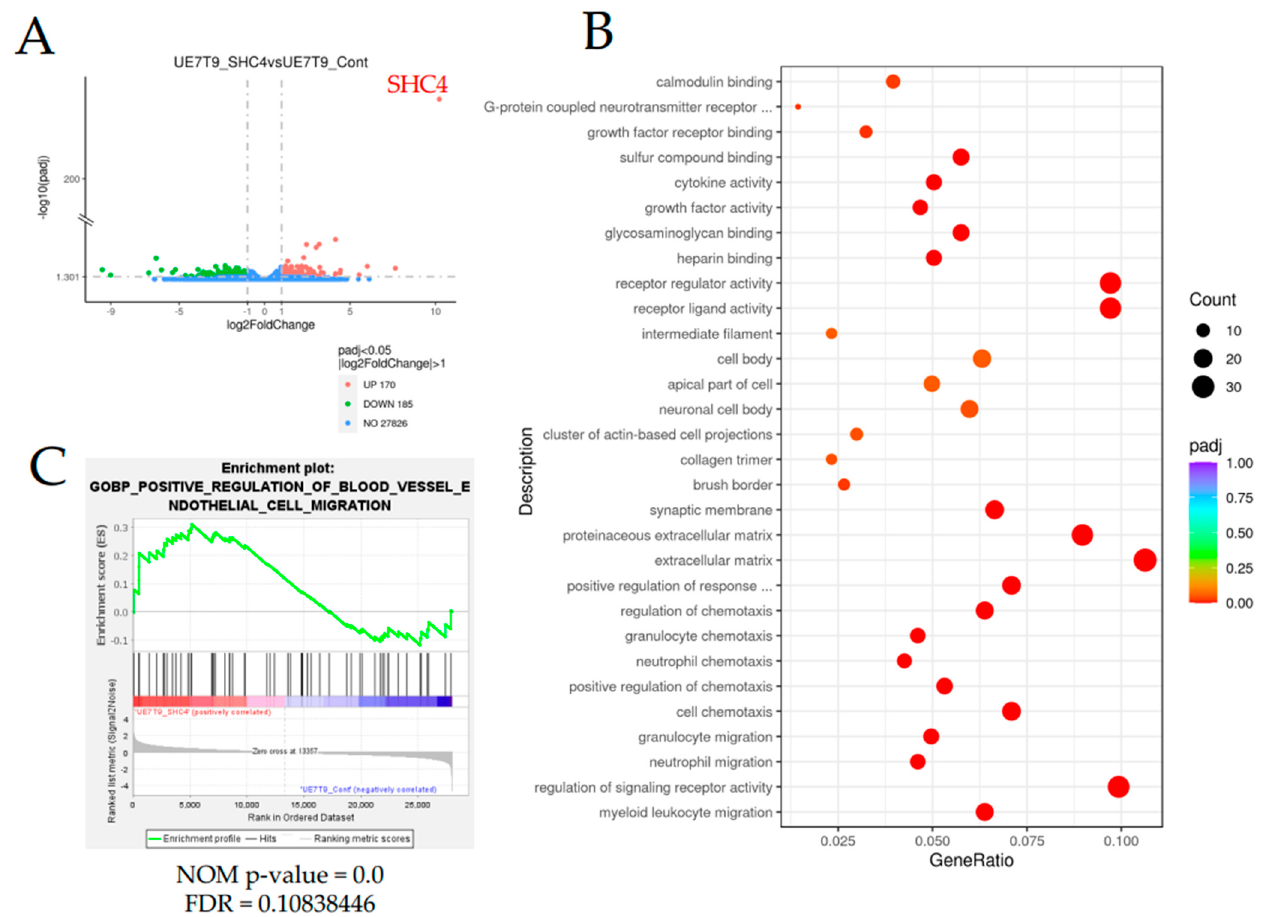
Figure 4. Results of RNA sequence analysis of UE7T-9 cell lines with increased SHC4 gene expression. ( A ) Volcano plot showing the distribution of genes expressed in UE7T-9 SHC4 according to their expression levels when compared to UE7T-9 Cont. The x-axis (log2FoldChange) shows the fold change in gene expression between different samples, and the y-axis (-log10(padj)) shows the statistical significance of the difference. Red dots represent upregulated genes, and green dots represent downregulated genes. ( B ) Pathway enrichment analysis shows the pathways to which the differential genes are most related, with reference to the Gene Ontology database. ( C ) Graphical views of the enrichment plot of the GSEA results for GOBP_Positive_Regulation_of_Blood_Vessel_Endo ‐ thelial_Cell_Migration.